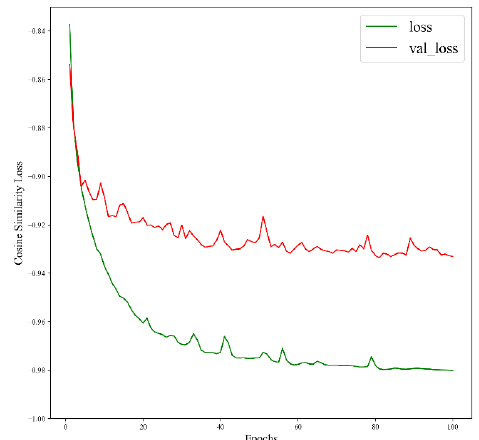
Figure 5. Cosine similarity loss curve in the training process for train and validation